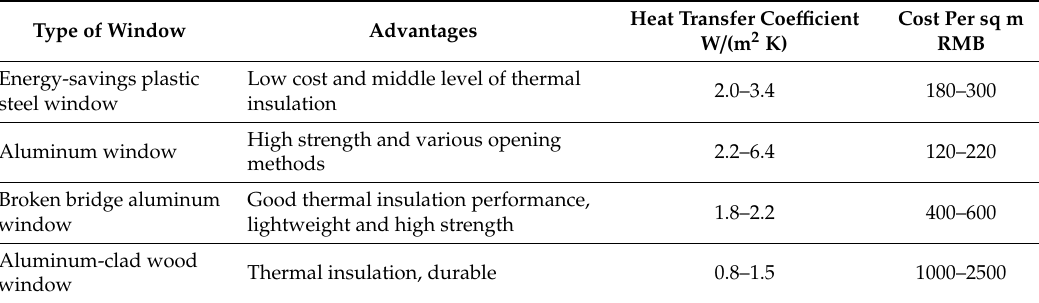
Table 2. Comparison of di ff erent types of